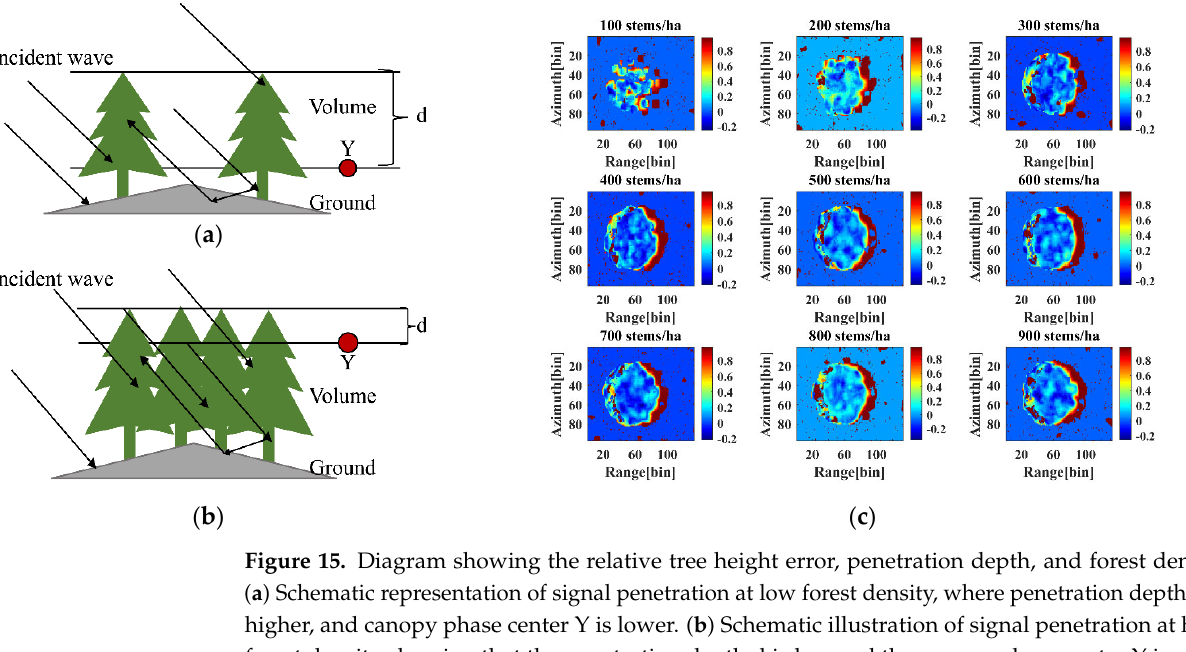
Figure 15. Diagram showing the relative tree height error, penetration depth, and forest density. ( a ) Schematic representation of signal penetration at low forest density, where penetration depth d is higher, and canopy phase center Y is lower. ( b ) Schematic illustration of signal penetration at high forest density showing that the penetration depth d is less and the canopy phase center Y is more elevated and closer to the canopy’s top. ( c ) The relative error (penetration depth) of the nine groups of forest stand inversions using the traditional three ‐ stage inversion method.